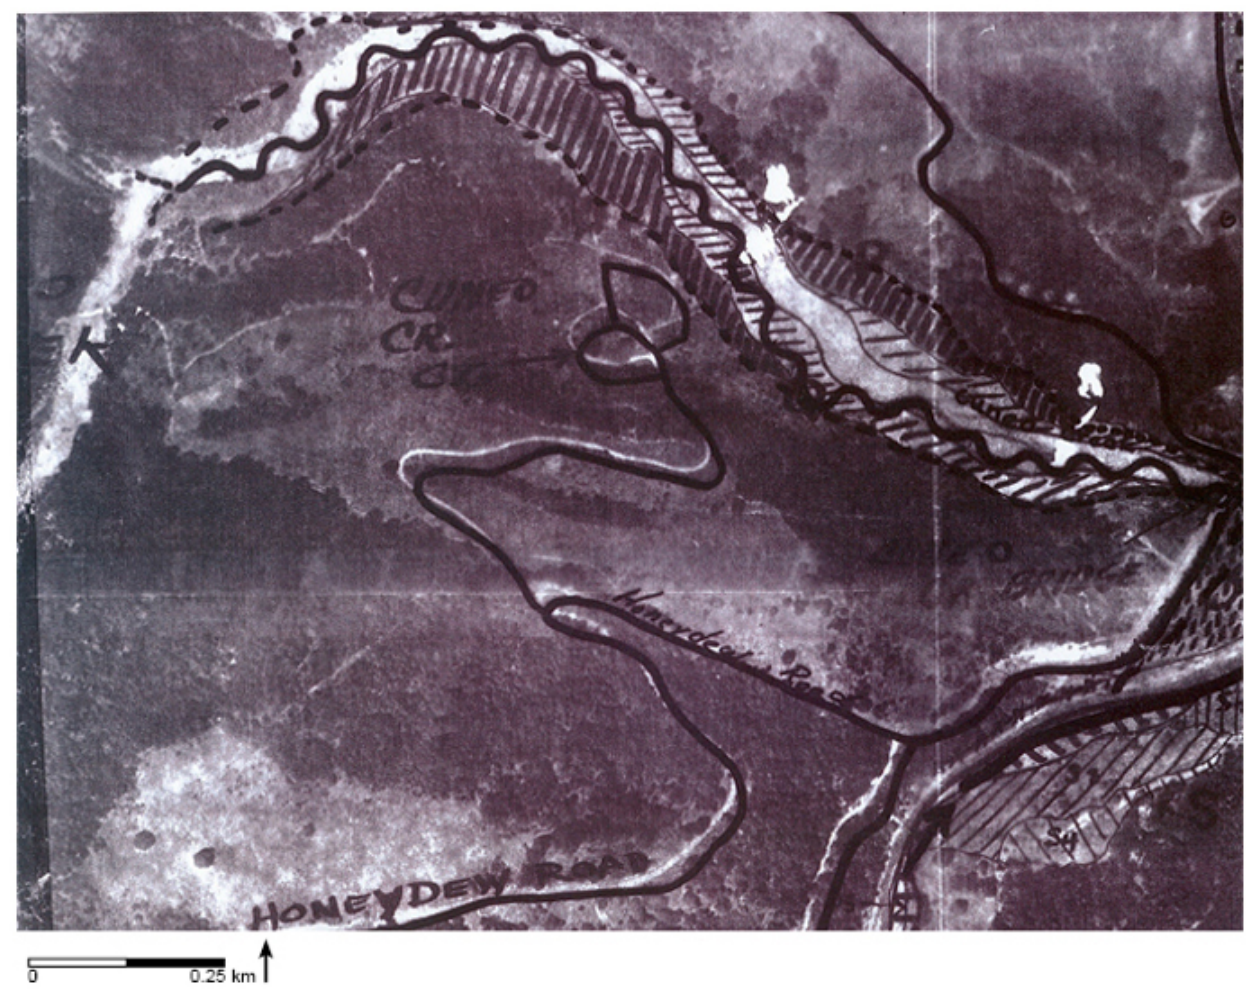
Fig. 5 . Design for Cuneo Creek reconstruction project (from Rosgen 1991). The bold, sinuous line is the proposed channel course drawn on a preproject aerial photography base (photography courtesy of the California Department of Parks and